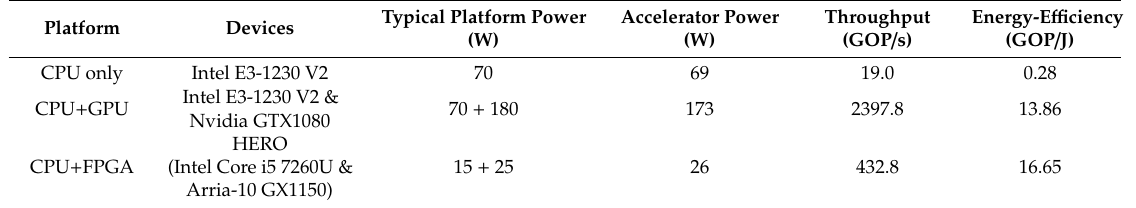
Table 1 . Comparison with other platforms with SegNet.